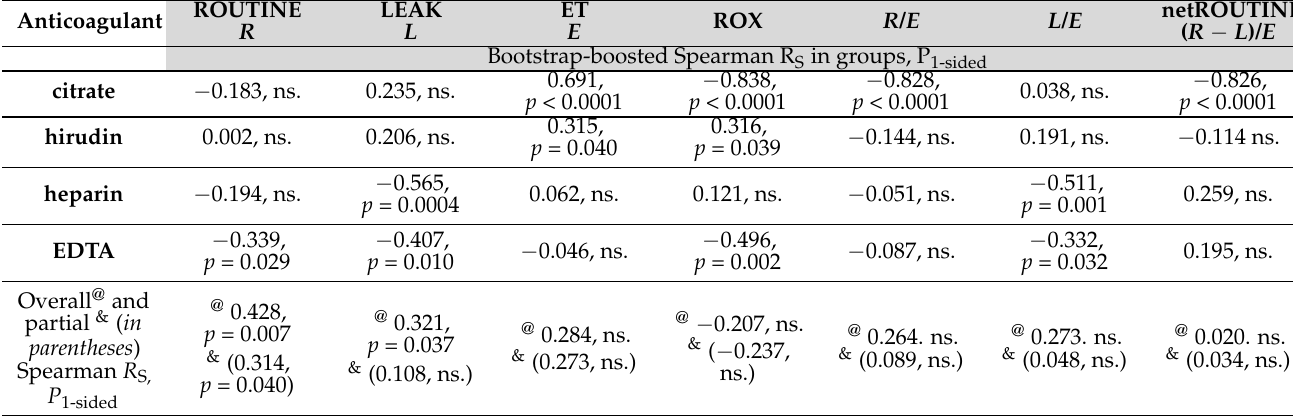
Table 2. Associations between mitochondrial respiration parameters and P-selectin expression and for blood platelets suspended in autologous plasma obtained from blood collected using various anticoagulants.